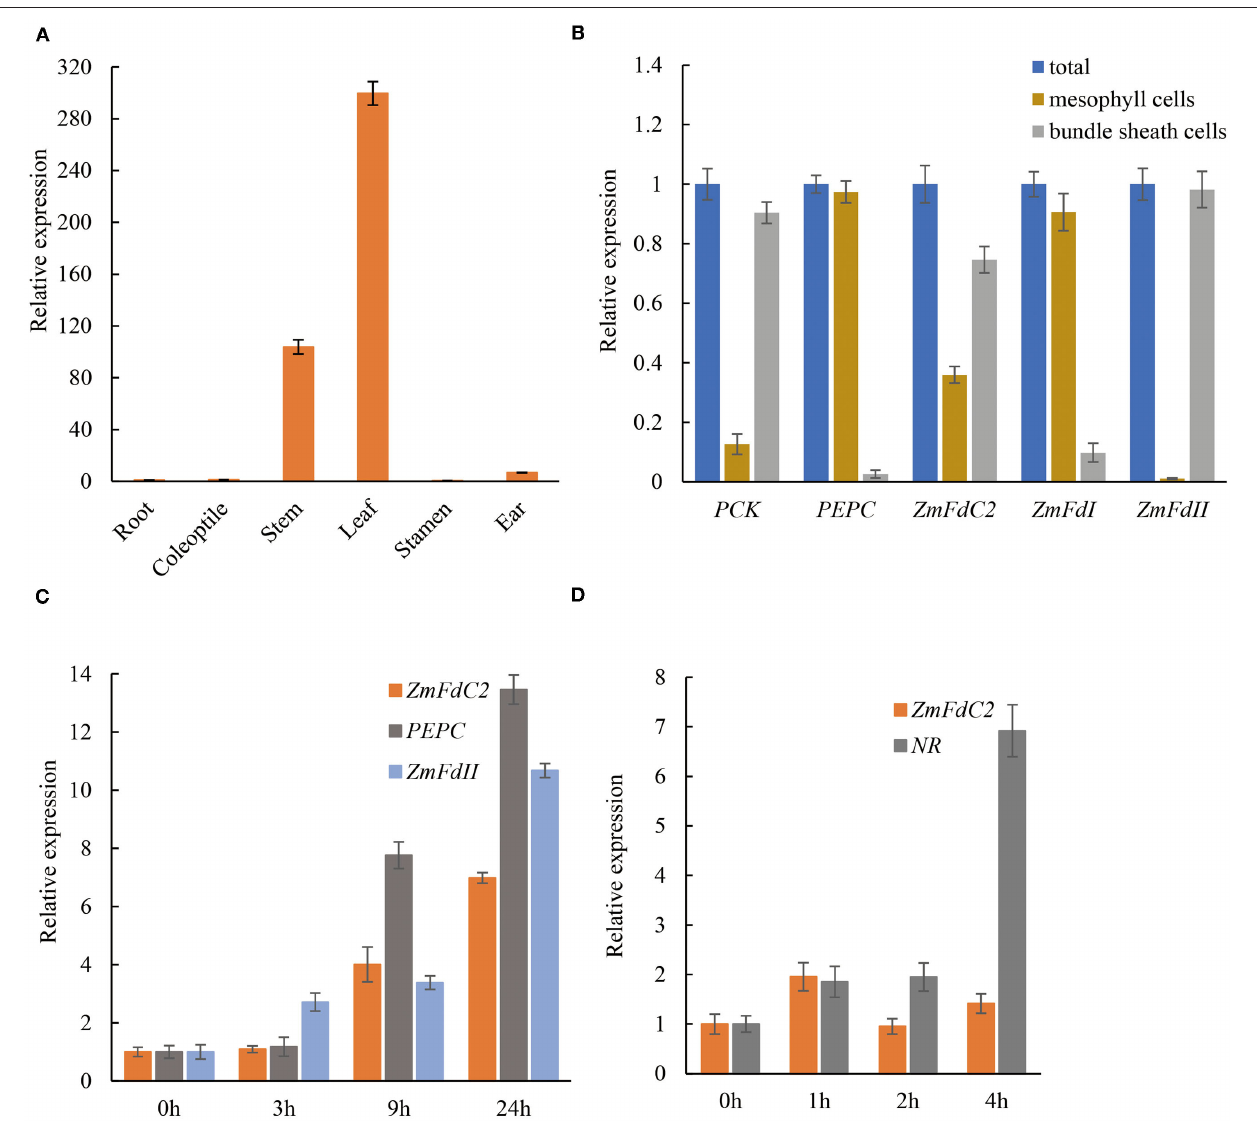
FIGURE 5 | Tissue specificity and light induction of ZmFdC2 expression. (A) , Real-time PCR of ZmFdC2 in different maize tissues. All expression values in different tissues were normalized to that of root. (B) , Expression of different genes in mesophyll cells and bundle sheath cells of maize leaves. The expression of each gene in two cell types was normalized to its expression in the total RNA. PEPC and ZmFdI served as positive control for mesophylls; PCK and ZmFdII served as positive control for bundle sheath cells. (C) , Real-time PCR of ZmFdC2 before and after light treatment. One-week-old seedlings grown in the dark were transferred to light and the youngest leaves were collected at different time points for RNA analyses. All expression values were normalized to that of 0h of light treatment. (D) , Real-time PCR of ZmFdC2 before and after nitrate addition. Two-week-old seedlings grown under low nitrate concentration (1.6mM KNO 3 ) were treated with 16mM KNO 3 , and the youngest leaves were harvested at different time points for RNA analyses. All expression values were normalized to 0h of nitrate treatment. All experiments were conducted for three biological replicates and results were presented as mean ± SD. Maize Actin gene served as internal control in all experiments except for (B)